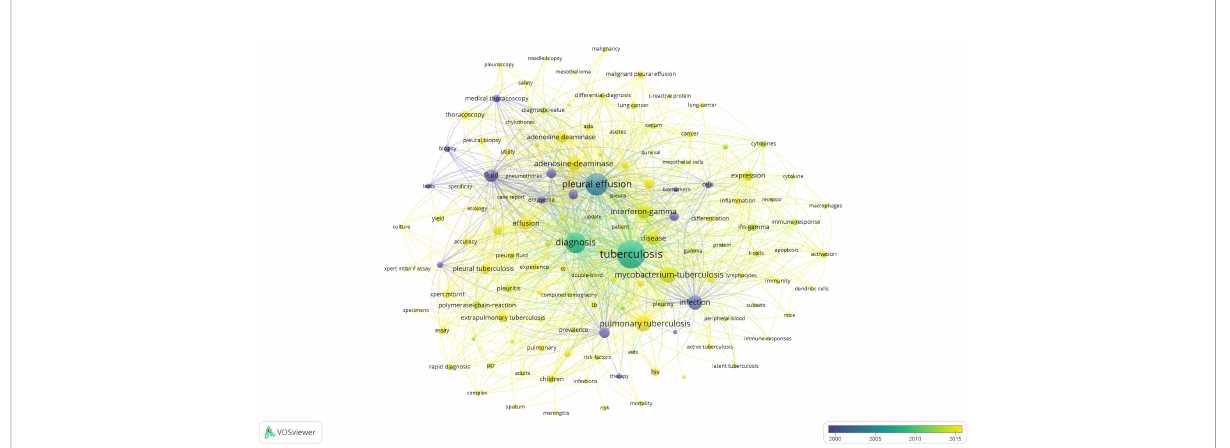
FIGURE 7 Visualization of keywords according to the APY. Keywords in yellow appeared later than that in